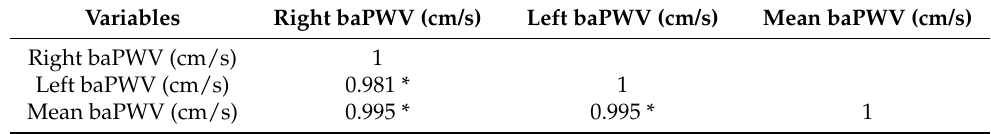
Table 2. Correlation matrix of right baPWV, left baPWV and mean PWV (Pearson’s correlation, n = 1056). Variables Right baPWV (cm/s) Left baPWV (cm/s) Mean baPWV (cm/s) Right baPWV (cm/s) 1 Left baPWV (cm/s) 0.981 *